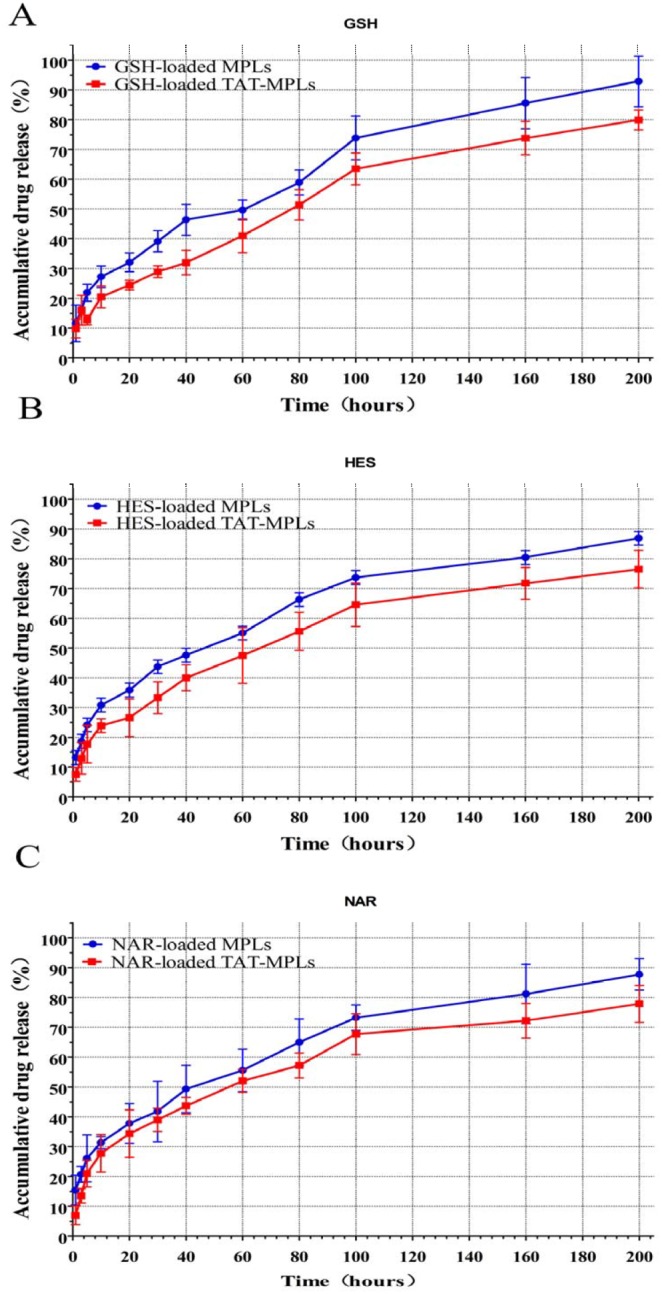
Drug release profiles of the TAT-conjugated MPLs in PBS (pH 7.4) at 37±0.5°C in

vitro.